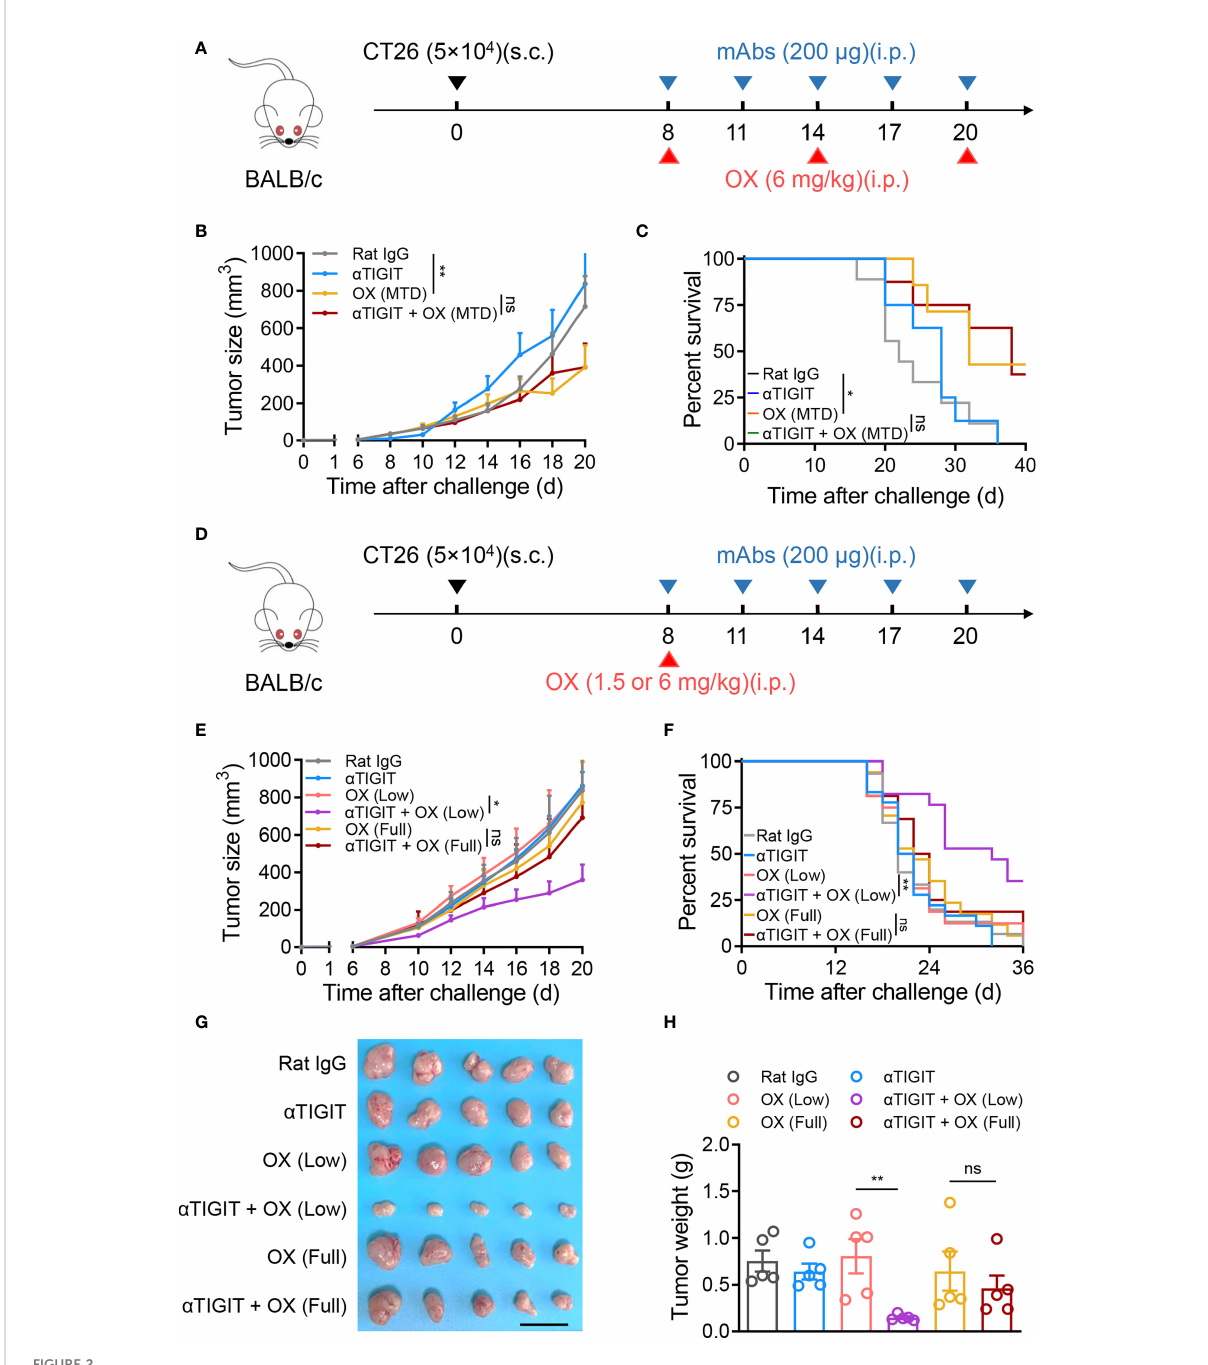
FIGURE 2 No synergistic antitumor activity offull-dose oxaliplatin and anti-TIGIT mAb. (A) , Experimental scheme for CT26 colon cancer model used in (B, C) . Mice were given injection of Rat IgG, anti-TIGIT mAb (10 mg/kg), OX (6 mg/kg), or anti-TIGIT mAb combined with OX intraperitoneally ( i.p. ) at various times after injection of 5×10 4 CT26 cells subcutaneously ( s.c. ) on day 0. (B) , Tumor size measurement at each time point. (n=6-8 mice per group). (C) , Overall survival of CT26-bearing mice with various treatments. (D) , Experimental scheme for CT26 colon cancer model used in (E – H) . Mice were given injection of Rat IgG, anti-TIGIT mAb, various-dose OX or anti-TIGIT mAb combined with various-dose OX intraperitoneally (i.p.) at various times after injection of 5×10 4 CT26 cells subcutaneously (s.c.) on day 0. (E) , Tumor size measurement at each time point. (n=6-8 mice per group). (F) , Overall survival of CT26-bearing mice with various treatments. (G) , Representative photograph and (H) weight of tumor (n = 5 per group) on day 21 after challenge. Scale bar represents 2 cm. Data were representative of at least two independent experiments. Error bars represent means ± SEM. Statistical signi fi cance was determined using two-way ANNOVA (B, E) , Mantel – Cox test (C, F) or one-way ANOVA followed by Tukey ’ s multiple-comparisons (H) . ns, p > 0.05; *p < 0.05 and **p <